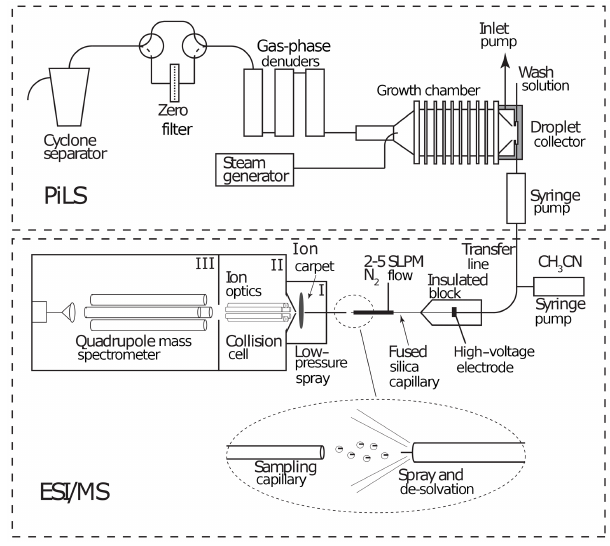
Figure 2. Schematic of a particle-into-liquid sampler (PILS; Sorooshian et al., 2006) interfaced to an electrospray ionization (ESI) source of a quadrupole mass spectrometer (MS) for continu- ous measurement of water-soluble components of atmospheric par-